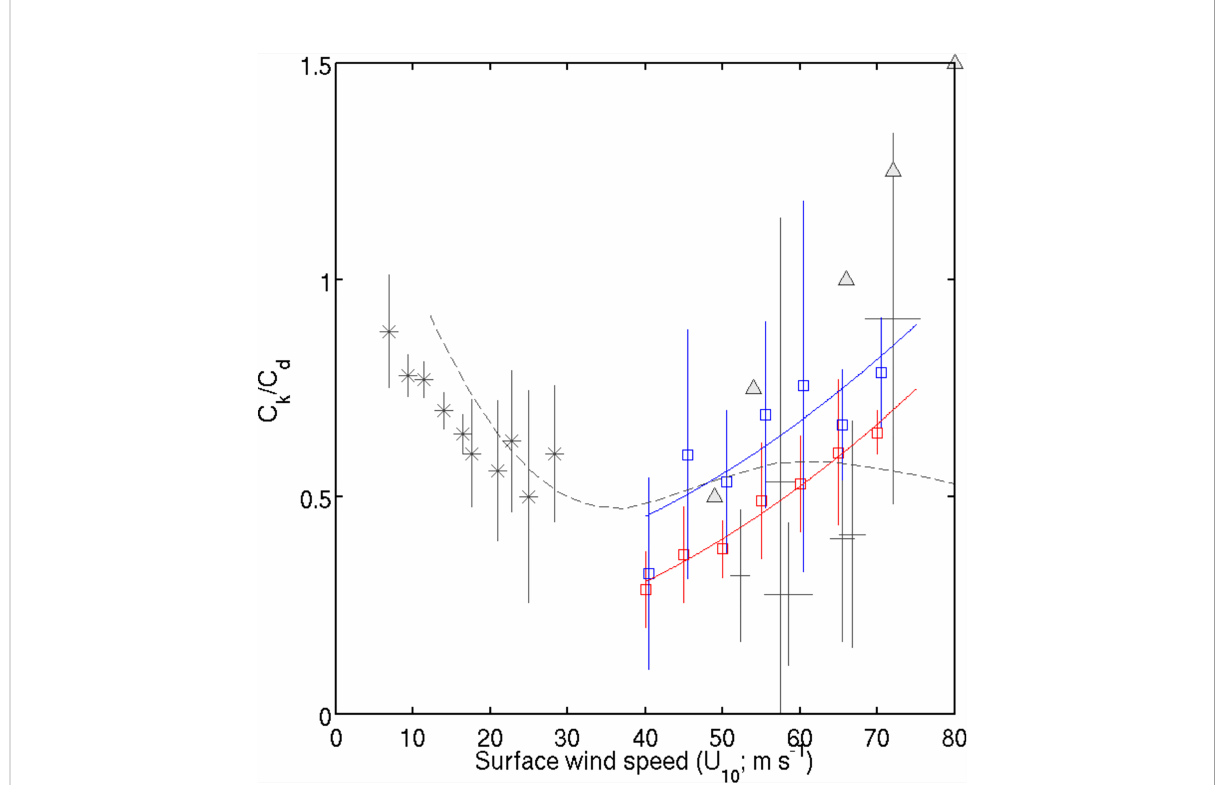
FIGURE 2 Dependence of C k /C d on U 10 based on prestorm SST and depth-averaged temperatures compared with previous studies. The red and blue squares indicate the mean values of C k / C d within each 5 m s − 1 interval of wind speed, estimated using prestorm SST and depth-averaged temperatures ( T 80 ), respectively. The color lines and error bars indicate linear fi ts and one standard deviation in the bins (the linear fi t of the blue line is 1.0943e-04 U 102 + 0.2799). The dashed gray lines indicate data adapted from Soloviev et al. (2014), and the gray triangles indicate data adapted from Emanuel (1995). The mean and 95% con fi dence intervals of diverse laboratory and measurement results (DeCosmo et al., 1996; Zhang et al., 2008; Haus et al., 2010; Bell et al., 2012) are shown in gray asterisks and solid